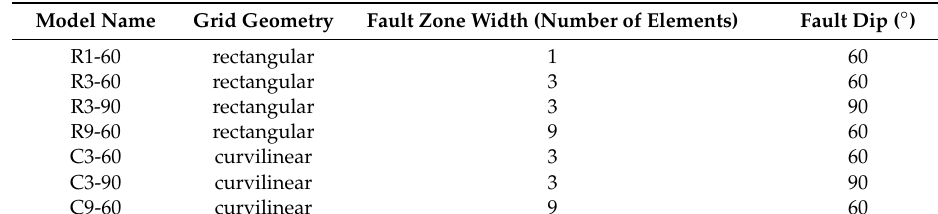
Table 1. Overview of the seven scenarios studied and the corresponding model names. The scenarios di ff er regarding the basic grid geometry, the mesh resolution of the fault zone and the fault dip.